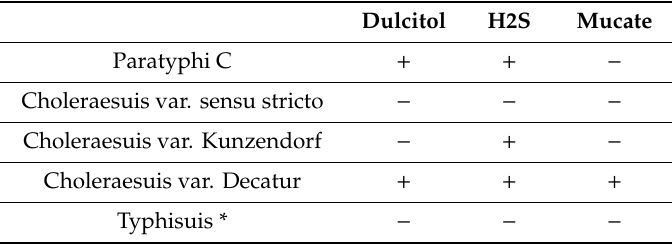
Table 1. Di ff erentiation by biochemistry of 6,7:c:1,5 Salmonella. Dulcitol H2S Mucate Paratyphi C + + − Choleraesuis var. sensu stricto − − − Choleraesuis var. Kunzendorf − +